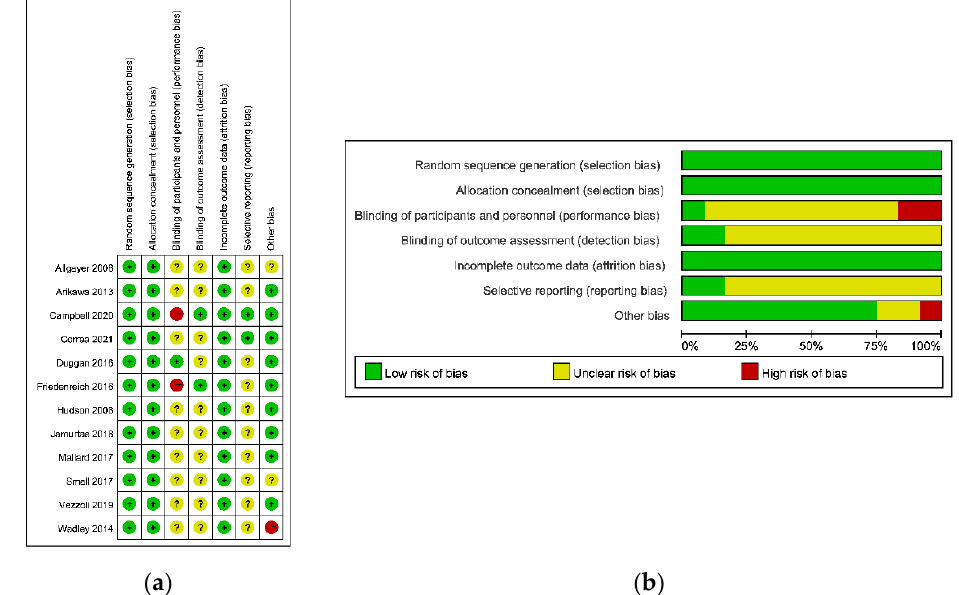
Figure 2. The risk of bias assessment. ( a ) Risk of bias summary; ( b ) risk of bias graph.